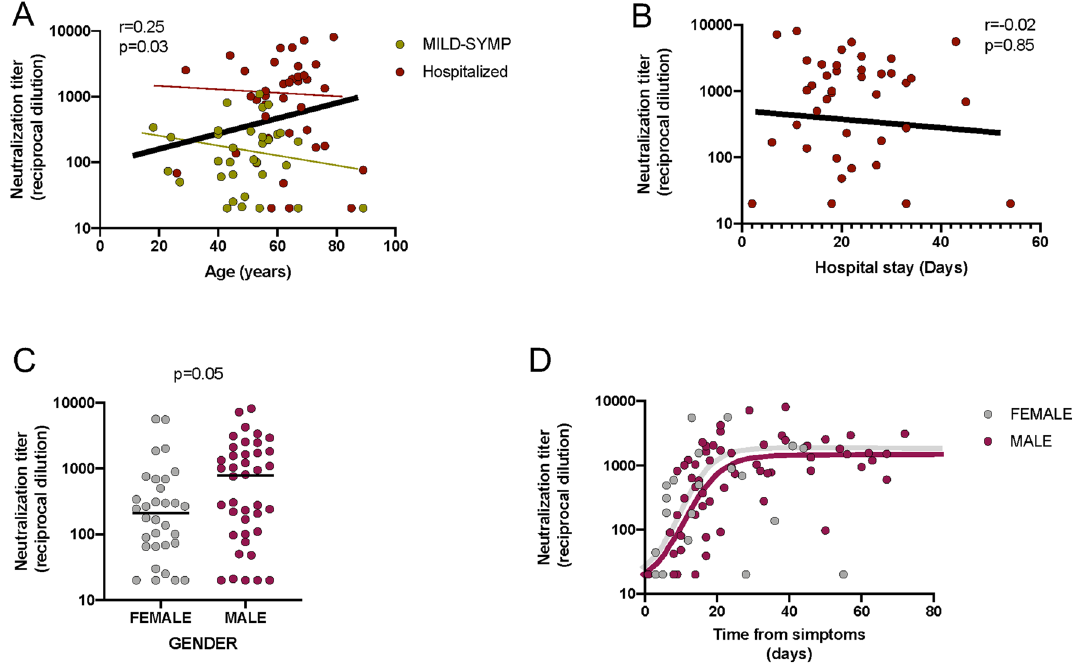
Figure 3. Factors associated with neutralizing responses. ( A ) Correlation between maximal individual neutralizing titers and age. P-value for Spearman’s test correlation of all data is shown (solid line), red and green dotted lines indicate correlations for hospitalized and mild-symptomatic individuals, respectively. P -value for Spearman’s test correlation is shown. ( B ) For hospitalized patients, correlation between neutralizing activity and duration of hospital stay. P -value for Spearman’s test correlation of data is shown (solid line). ( C , D ) Analysis of gender differences in the maximal neutralization titer value of COVID-19 participants (n = 73, C ) and in hospitalized participants (n = 40, panel D). P -values for Mann–Whitney tests is shown.